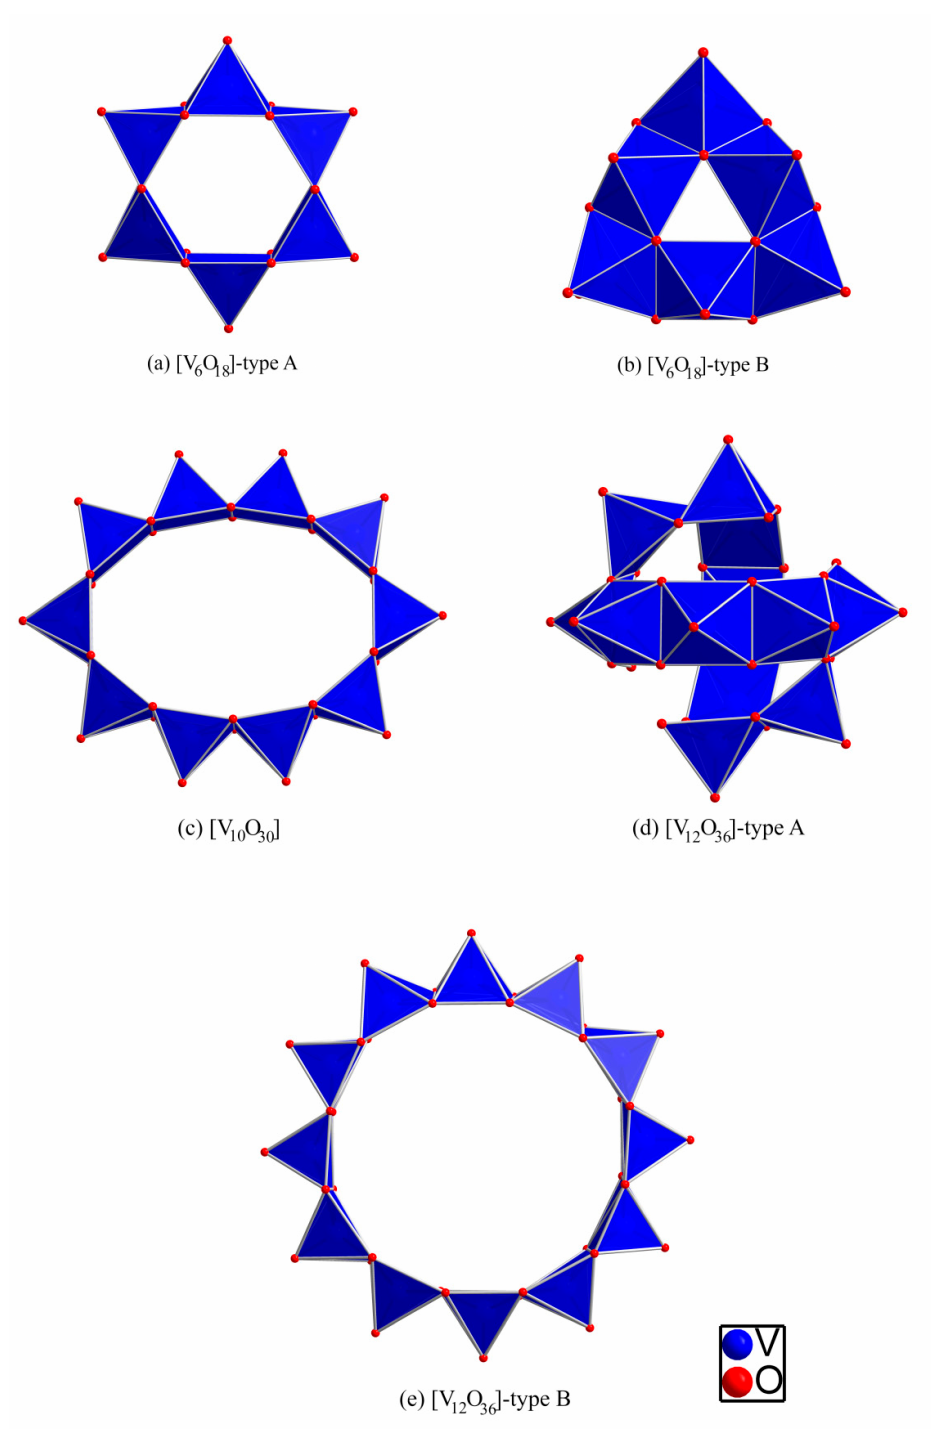
Figure 1. Polyhedral representation of the vanadate